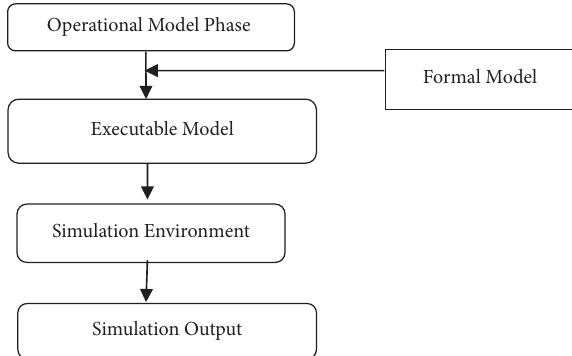
Figure 3: Simulation phase activities Table 1: Te model concept.